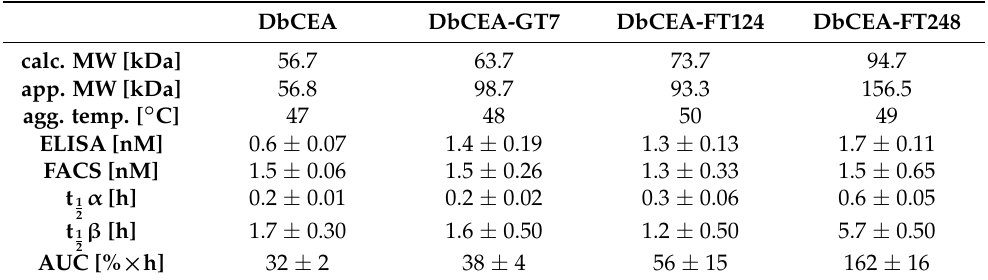
Figure 1. Sequence and schematic illustration of GlycoTAIL and FlexiTAIL molecules. ( A ) Se- quence of designed GlycoTAIL and FlexiTAIL. The GlycoTAIL moiety consist of 55 amino acids and 7 N-glycan sites, while a single FlexiTAIL moiety consist of 62 amino acids without any N-glycan sites. N-glycan sites are highlighted in gray. ( B ) Schematic illustration of monovalent and bivalent antibody molecules. The scFv and diabody is shown in light gray, EHD2 [23] is shown in gray. Table 2. Biochemical, binding, and pharmacokinetic properties of Db-based molecules. Mean ± SD, n = 3.